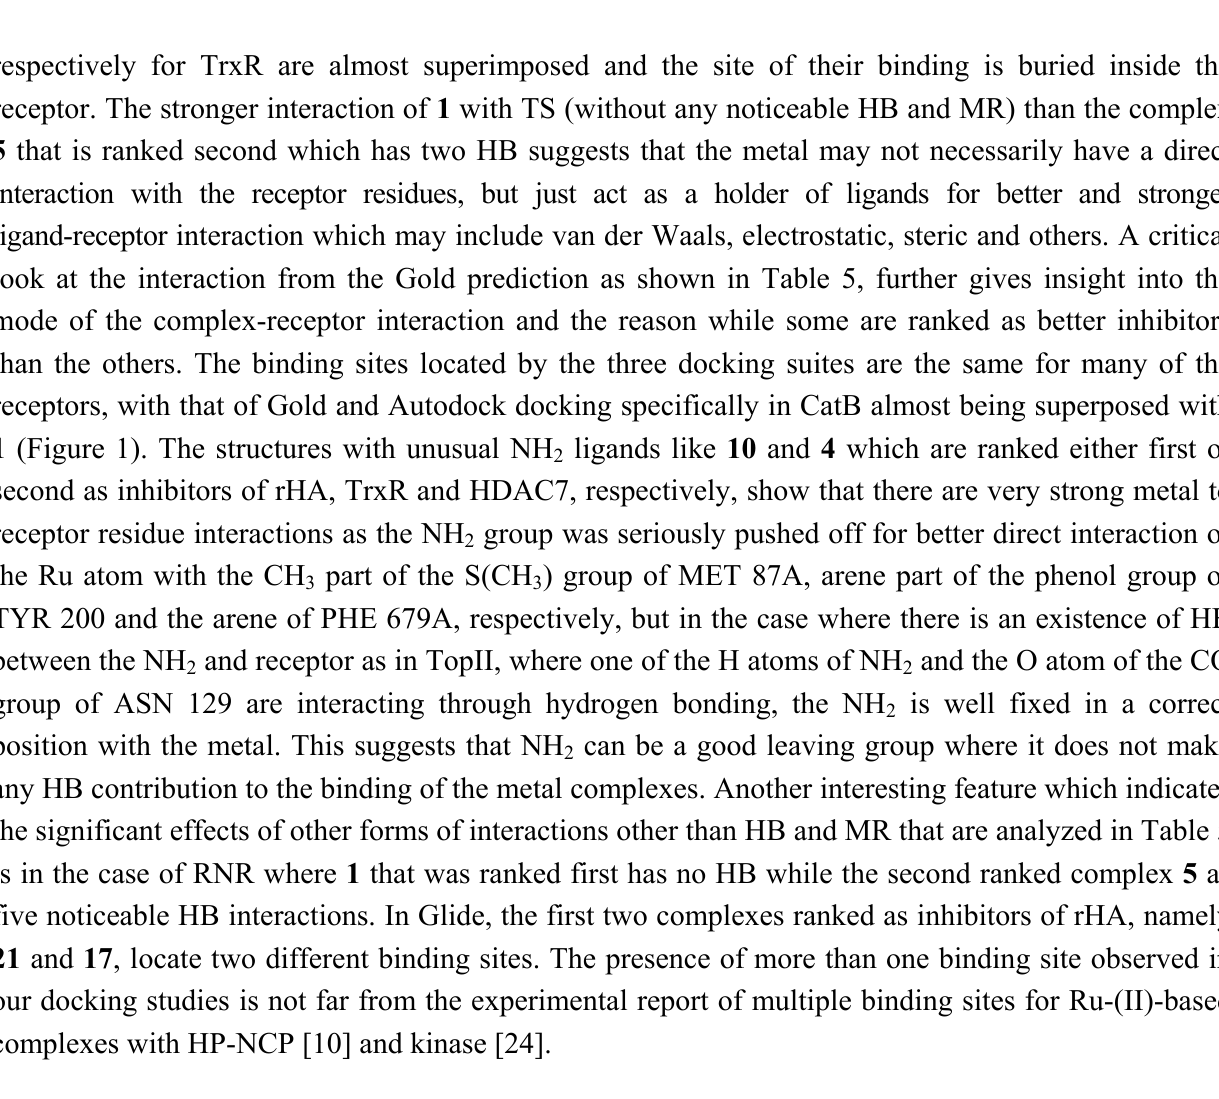
Table 5. The interaction of the binding site residues with first two rank best inhibitors complexes from the three docking methods defining the Complex-receptor existing Hydrogen Bond (HB) and Metal-Receptor (MR) possible interactions with residues within the range of 4.5 Å